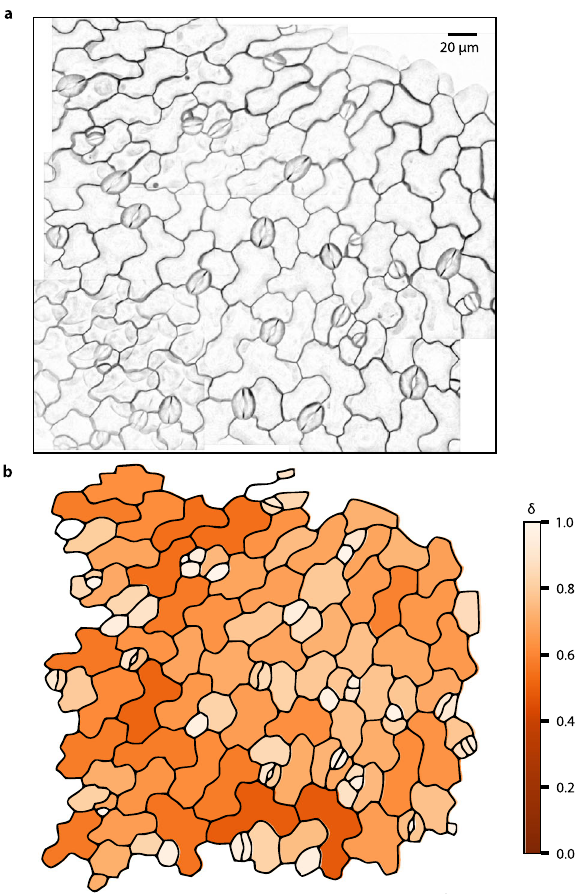
Fig. 4 Heatmap of Arabidopsis pavement cell completeness. a Example microscopy image of Arabidopsis pavement cells at 96 h after germination (single image). b The original microscopy image can be recreated by plotting the extracted visibility graphs of all detected pavement cells and weighting them according to their relative completeness ( δ ), which is calculated by the relative density of the corresponding visibility graphs. Simple, round shapes like stomata have smaller relative completeness (white) in comparison to the more complex pavement cell shapes (dark orange). Source data are provided as a Source Data fi